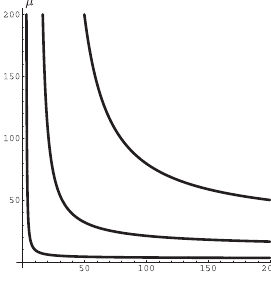
Figure 1. The Neumann problem: classical